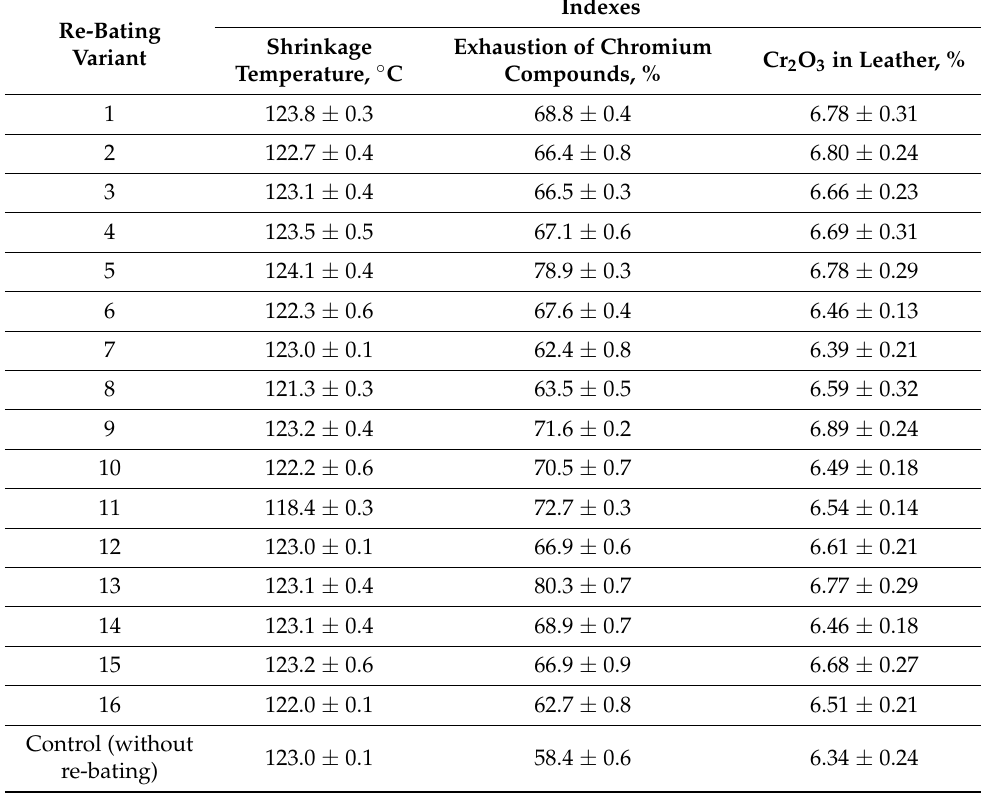
Figure 1. FTIR spectra of untreated wet blue (1) and after enzymatic treatment of wet blue with Zime SB 1% (2); Zime SB 5% (3); NovoBate WB 1% (4); NovoBate WB 5% (5); Oropon DVP 1% (6); Oropon DVP 5% (7); Oropon WB 1% (8); Oropon WB 5% (9). After re ‐ bating, other post ‐ tanning operations must be performed to achieve the de ‐ Table 5. Influence of re-bating process on WB re-chroming and shrinkage sired properties of the finished product. In this study, first, re ‐ chroming with all 16 vari ‐